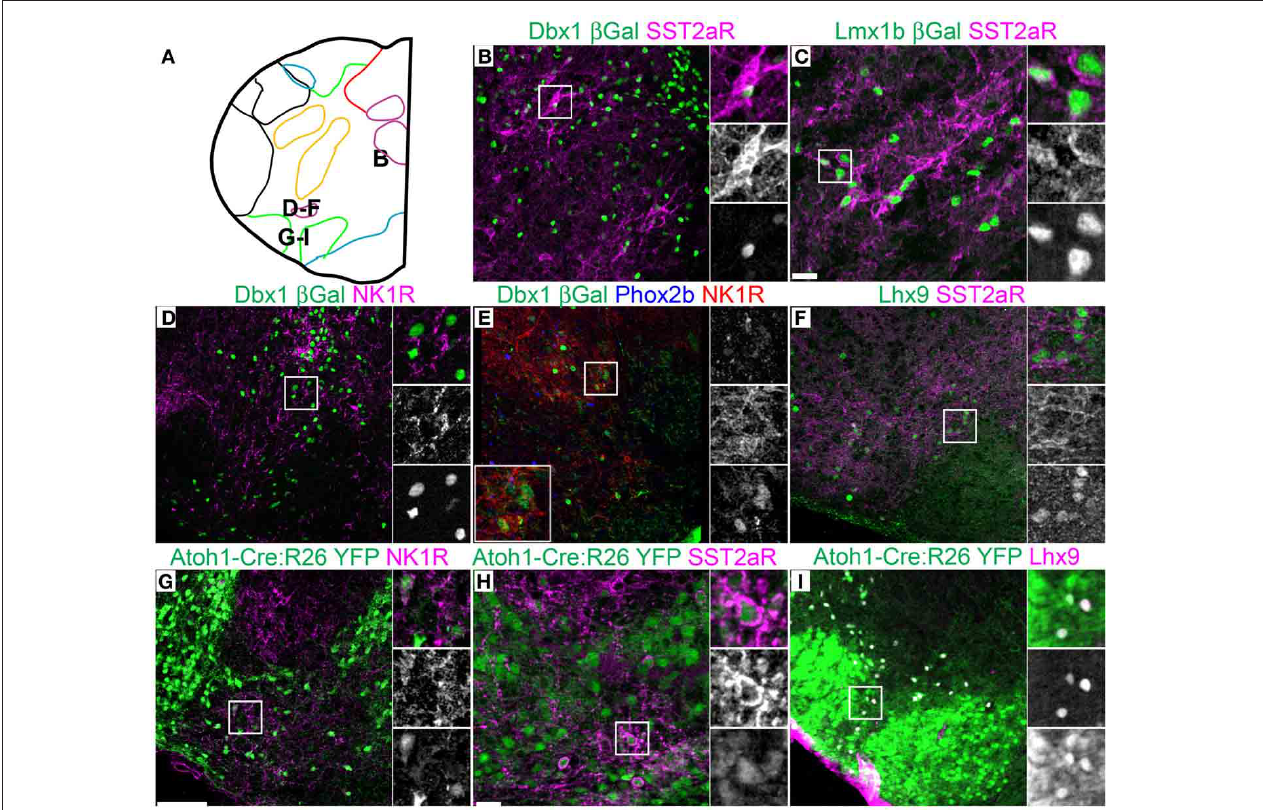
FIGURE 7 | Pseudo-rhombomere 9 specific patterns of gene expression. Pseudo-color fluorescent confocal mosaic images from P0 transgenic mouse at the level of pseudo-rhombomere9. (A) Schematic image modified from Figure 2G indicating location of co-expressing populations shown in (B–I) . ( B–I) Images from Dbx1- β gal (B,D,E) , Lmx1b- β gal (C) , wild type (F) , and Atoh1 -Cre; R26YFP (G–I) mice showing localization of lineage reporter